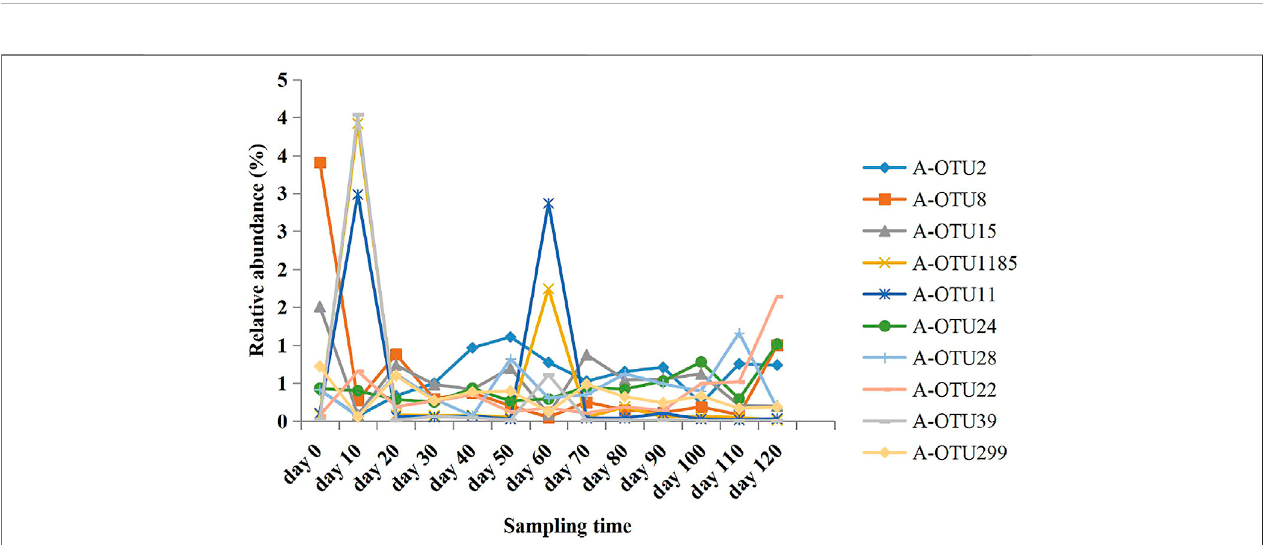
FIGURE 3 | Relative abundance variation of the 10 most abundant methanogenic archaeal OTUs at different anaerobic digestion time.